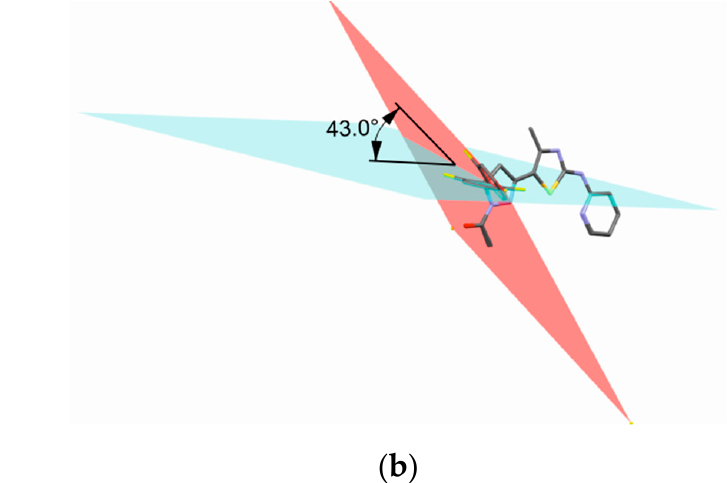
Figure 6. ( a ) Overlay of two symmetry-independent molecules A (red) and B (blue) by the least-squares fitting of the 4-methyl-1,3-tiazole systems; ( b ) 3D stick representation with indicated planes of phenyl ring in molecules A (pink plane) and B (blue plane). Table 2. Hydrogen bonds and C—H ··· Cg interactions (Å, °) in the crystal structure of 6 .